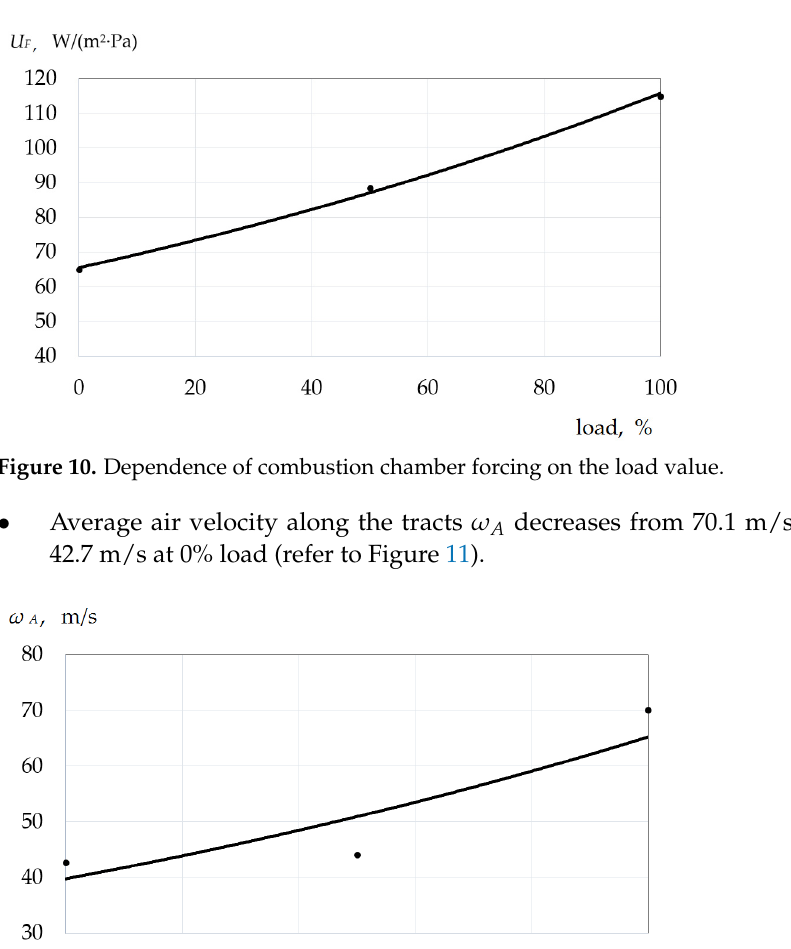
Figure 9. Dependence of the total throughput area along the tracts of one combustion chamber on the load value.